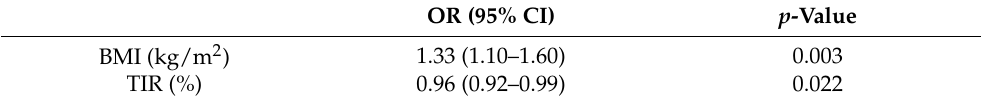
Table 3. Multiple logistic regression analysis of factors associated with a high score on the